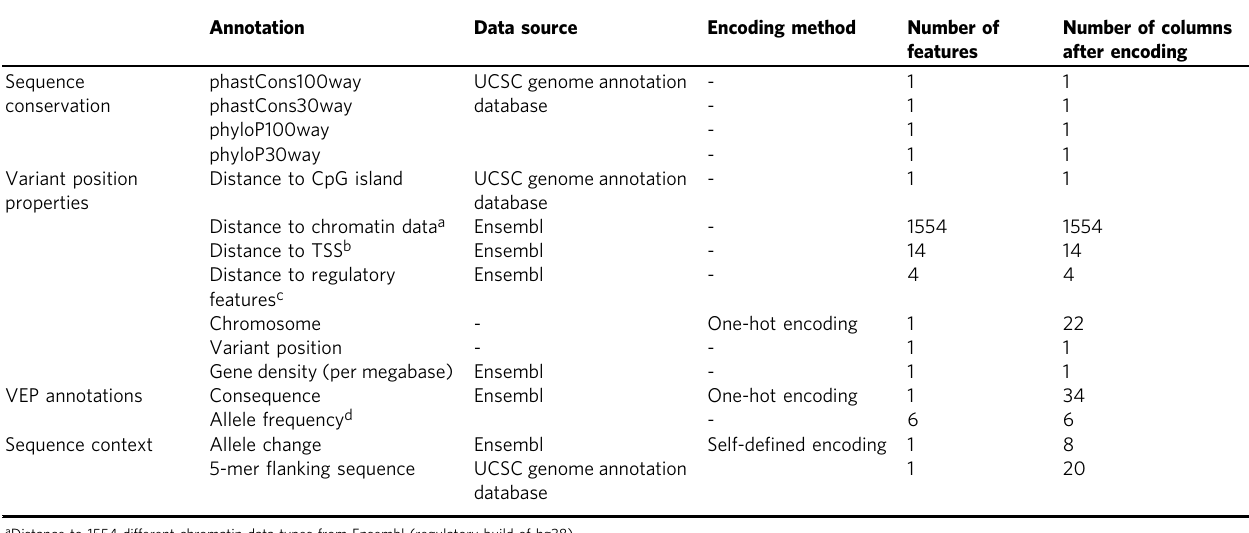
Fig. 1 Frequency of variant sharing across species. a Number of human (1000 genomes) SNPs that have a SNP at the orthologous location in each other species. Counts are broken down into where the SNPs have the same alleles across species (same site and alleles) or simply coincide, i.e. irrespective of allele change. The inset shows the number of orthologous SNPs expected in larger cohorts when extrapolating the curves. b The number of human variants overlapping a variant found in one or more other species with a matching allele change. The vertical bars indicate the number of human orthologues found across the species indicated by the dots below. The horizontal bars indicate the total number of orthologues in that species. The data underlying this plot can be found in Supplementary Data 1. Table 1 Variant annotations used in the modelling and their encoding